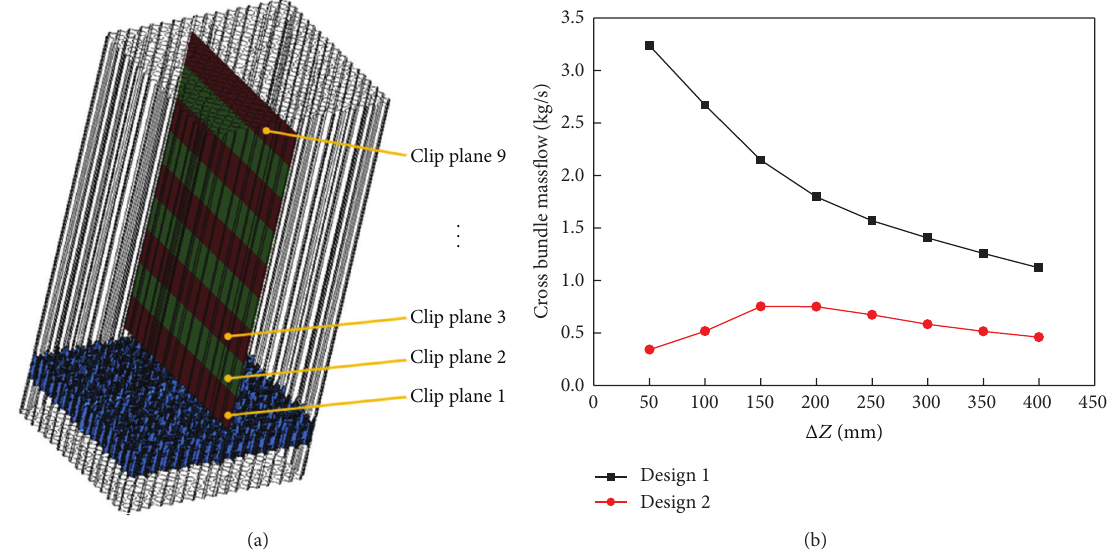
Figure 8: Cross-bundle mass flow at different axial location.